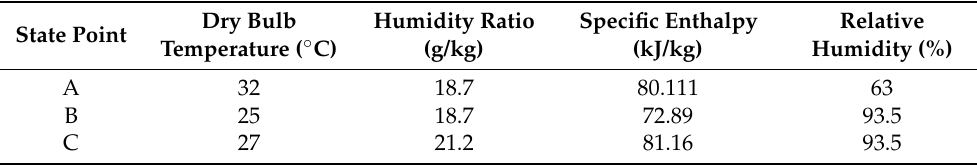
Table 6. Air state parameters for the hybrid